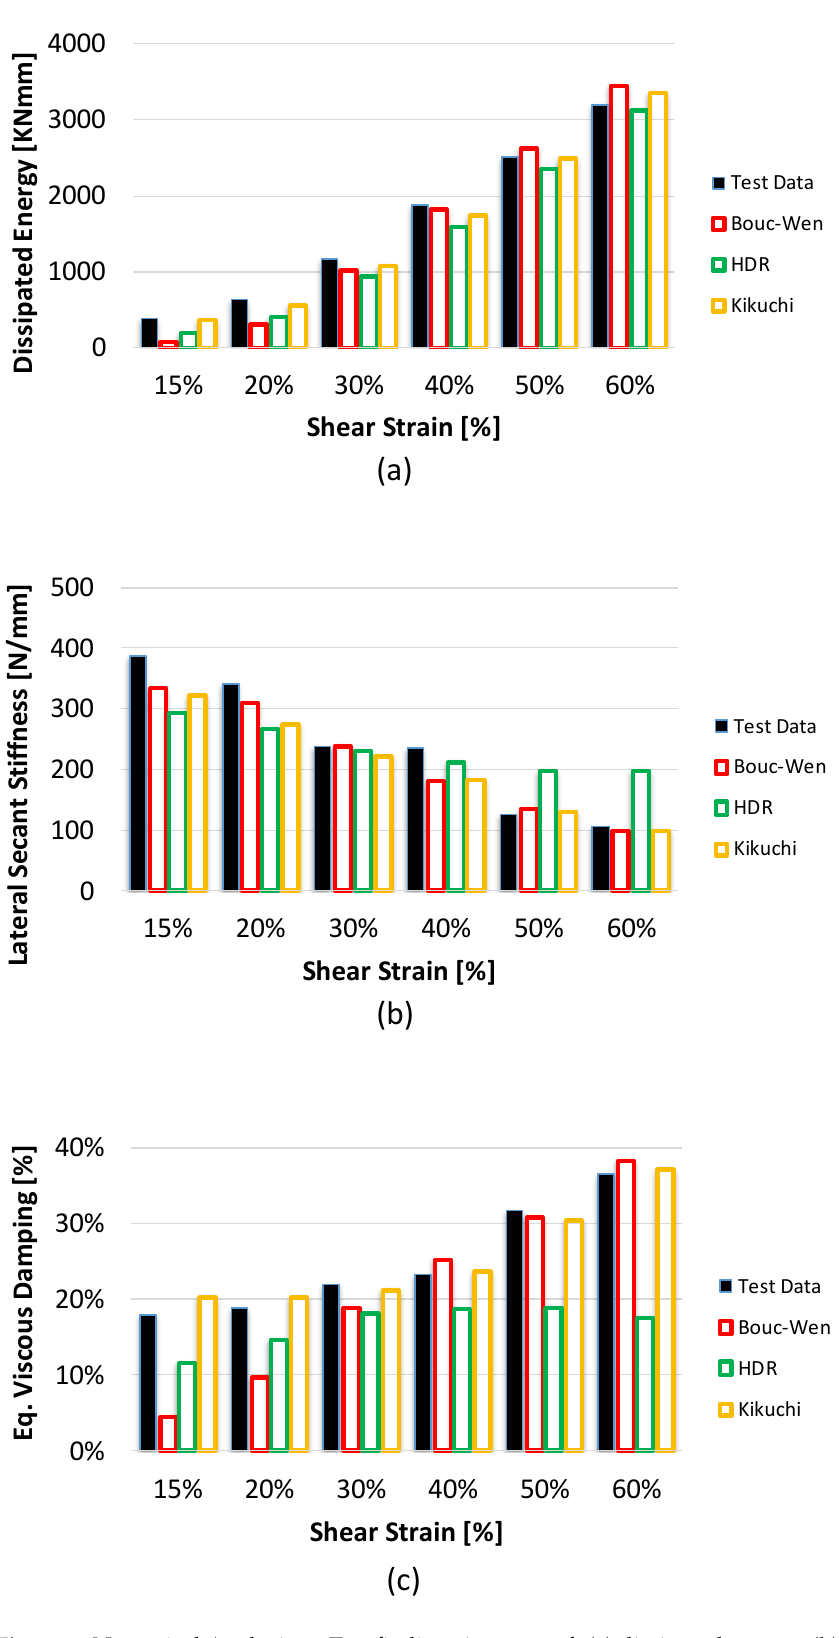
Figure 8. Numerical Analysis vs Test findings in terms of: ( a ) dissipated energy; ( b ) lateral secant stiffness; and ( c ) equivalent viscous damping.